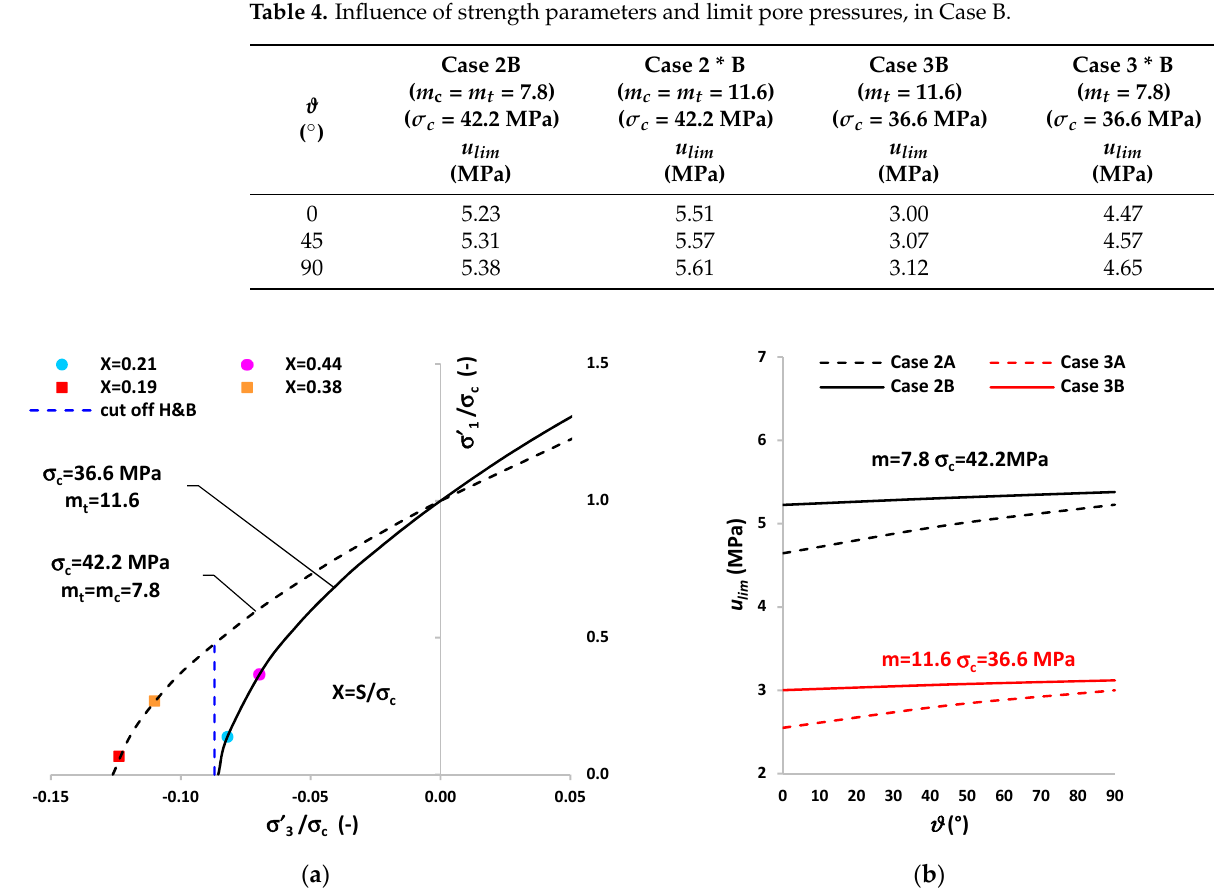
Table 4. Influence of strength parameters and limit pore pressures, in Case B.